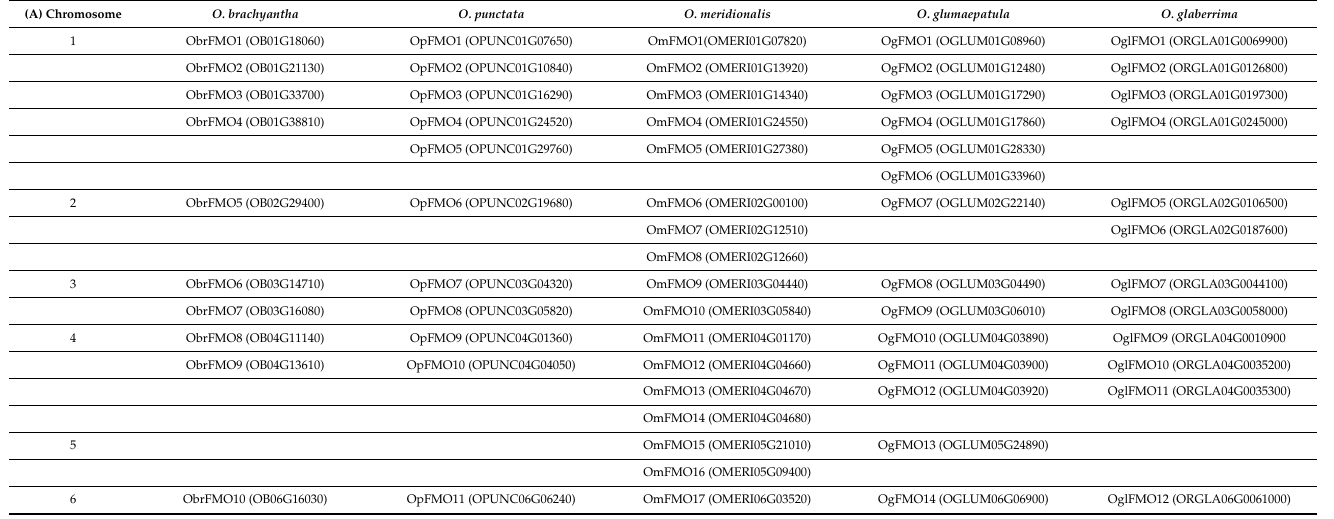
Table 1. Identification and nomenclature of FMO encoding genes in wild and cultivated rice. The names of the FMO encoding genes identified, from the Ensembl Gramene database, have been assigned according to increasing order of chromosomal distribution. Suffixes of OsI, OsJ, Osgl have been apportioned to the cultivated varieties indica, japonica and glaberrima respectively and Oba, Obr, On, Om, Or and Op have been allocated to O. barthii , O. brachyantha , O. nivara , O. meridionalis , O. rufipogon and O. punctata , respectively. (A) shows nomenclature for O. brachyantha , O. punctata , O. meridionalis , O. glumaepatula , O. glaberrima and (B) show nomenclature for O. barthii , O. nivara , O. indica , O. rufipogon and O. japonica . In the table, each rice chromosome is indicated by a different colored